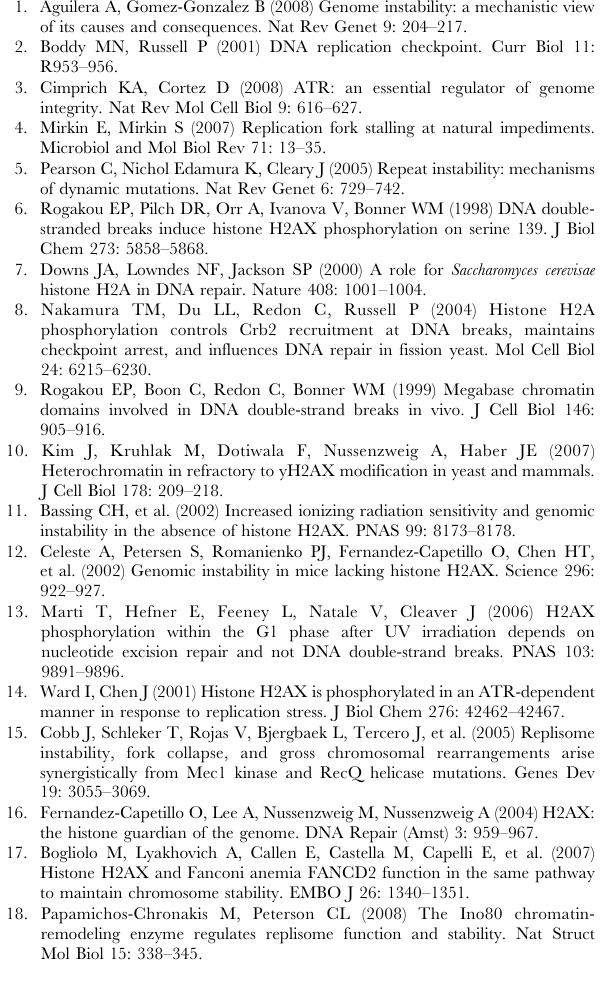
Table S3 QPCR primers used in this